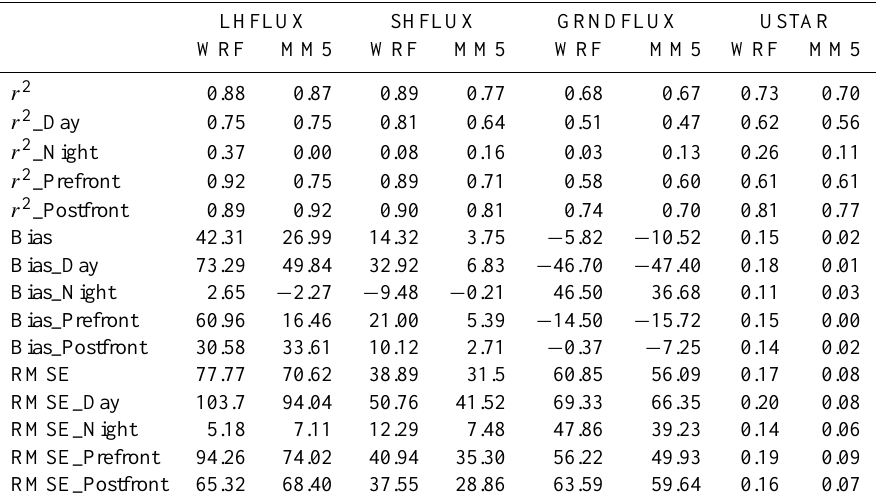
Table 7. Results for r 2 and bias for all, diurnal, and frontal conditions for latent heat flux (LHFLUX), sensible heat flux (SHFLUX), ground flux (GRNDFLUX), and friction velocity